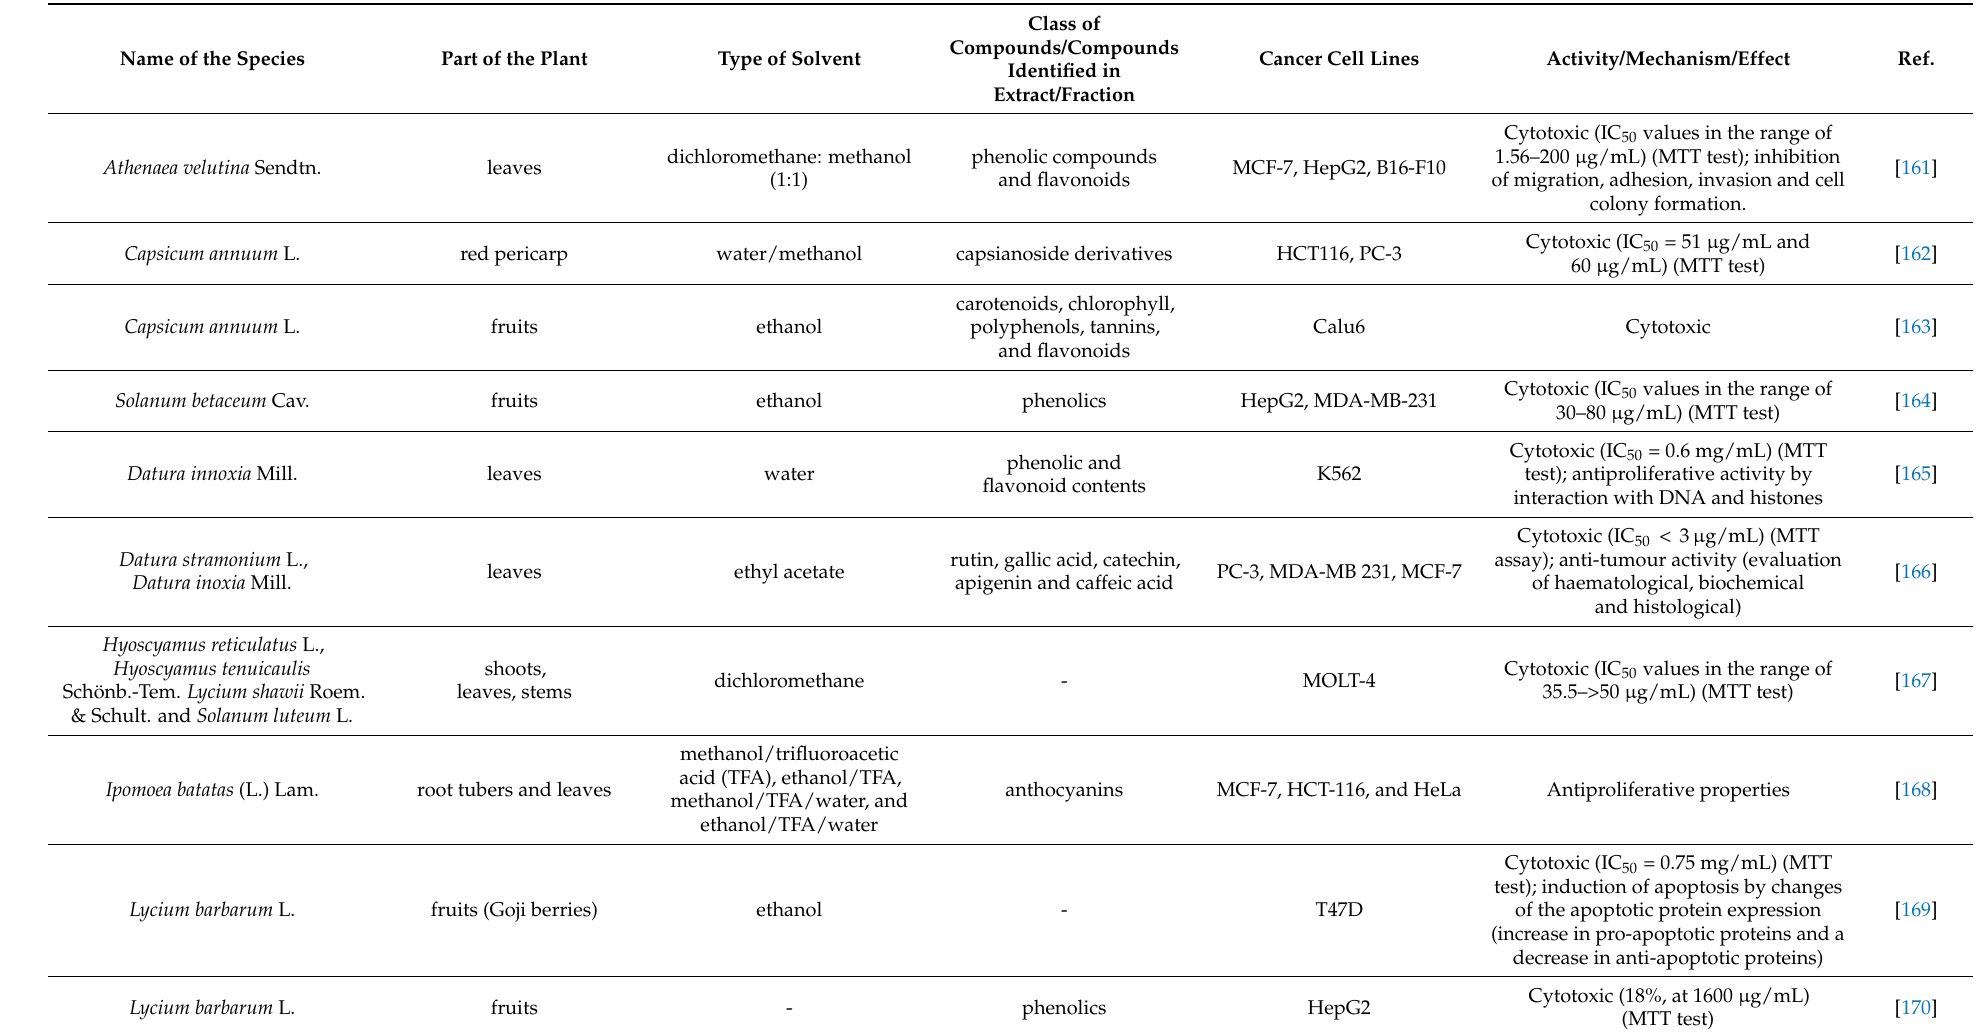
Table 1. In vitro anticancer effect of plant extracts from the Solanaceae family and their potential mechanisms of